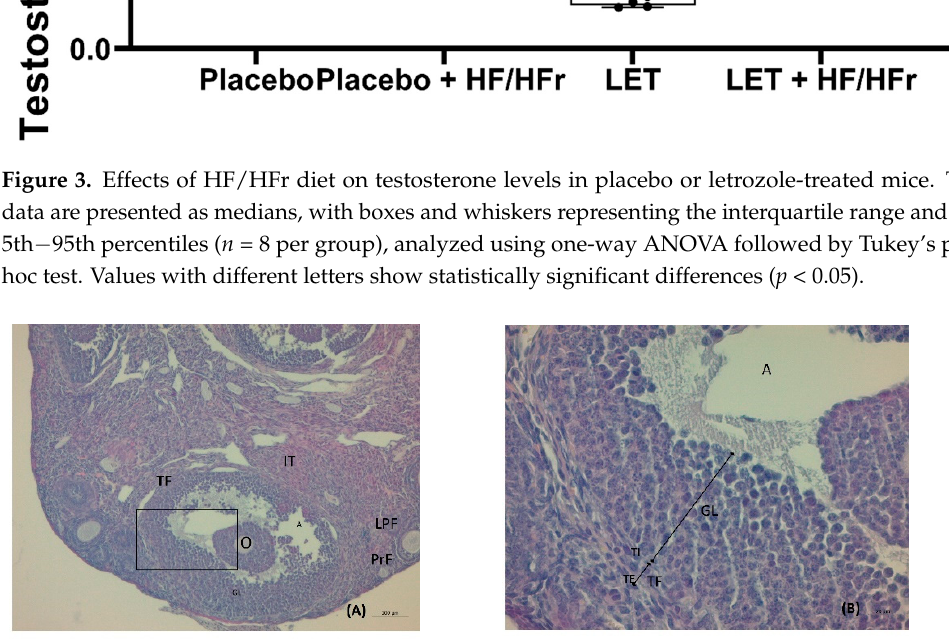
Figure 5. Histological sections of the ovaries with atretic follicles (AF) in intact mice on the HF/HFr diet. TF: tertiary follicle; PF: primary follicle; SF: secondary follicle; CL: corpus luteum; IT: interstitial tissue; O: oocyte; GL: granulosa cells in the process of degradation (H&E; power 100×( A )/200×( B )).